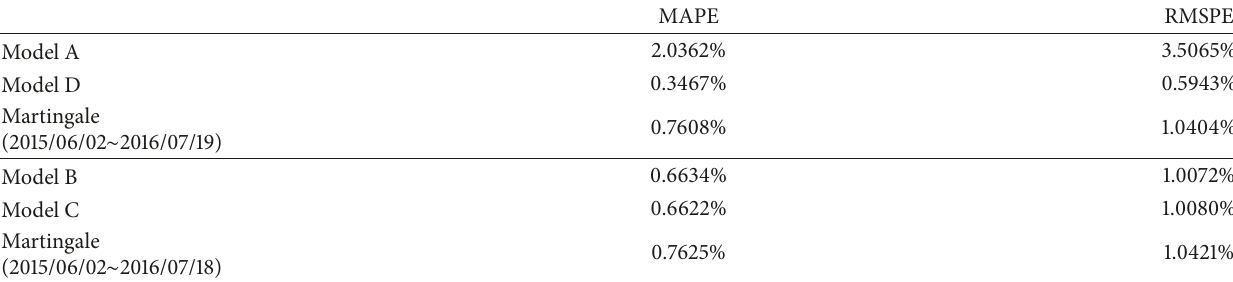
Table 2: MAPEs and RMSPEs, fits of the four dynamic models and the martingale.